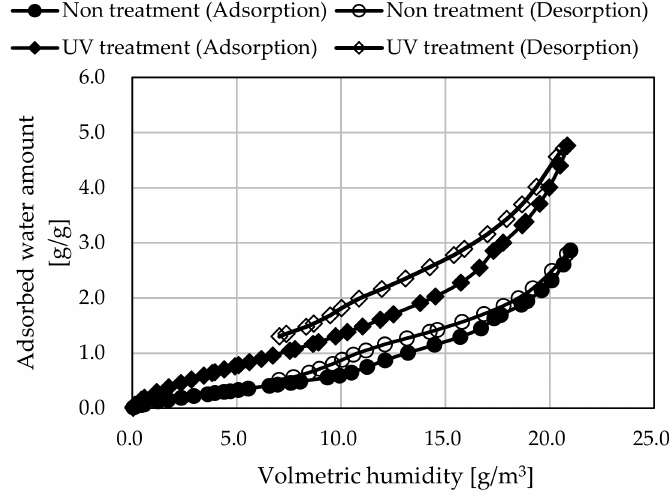
Figure 2. Water vapor adsorption isotherms of the untreated and UV-pretreated samples (Using pure PPS powder).